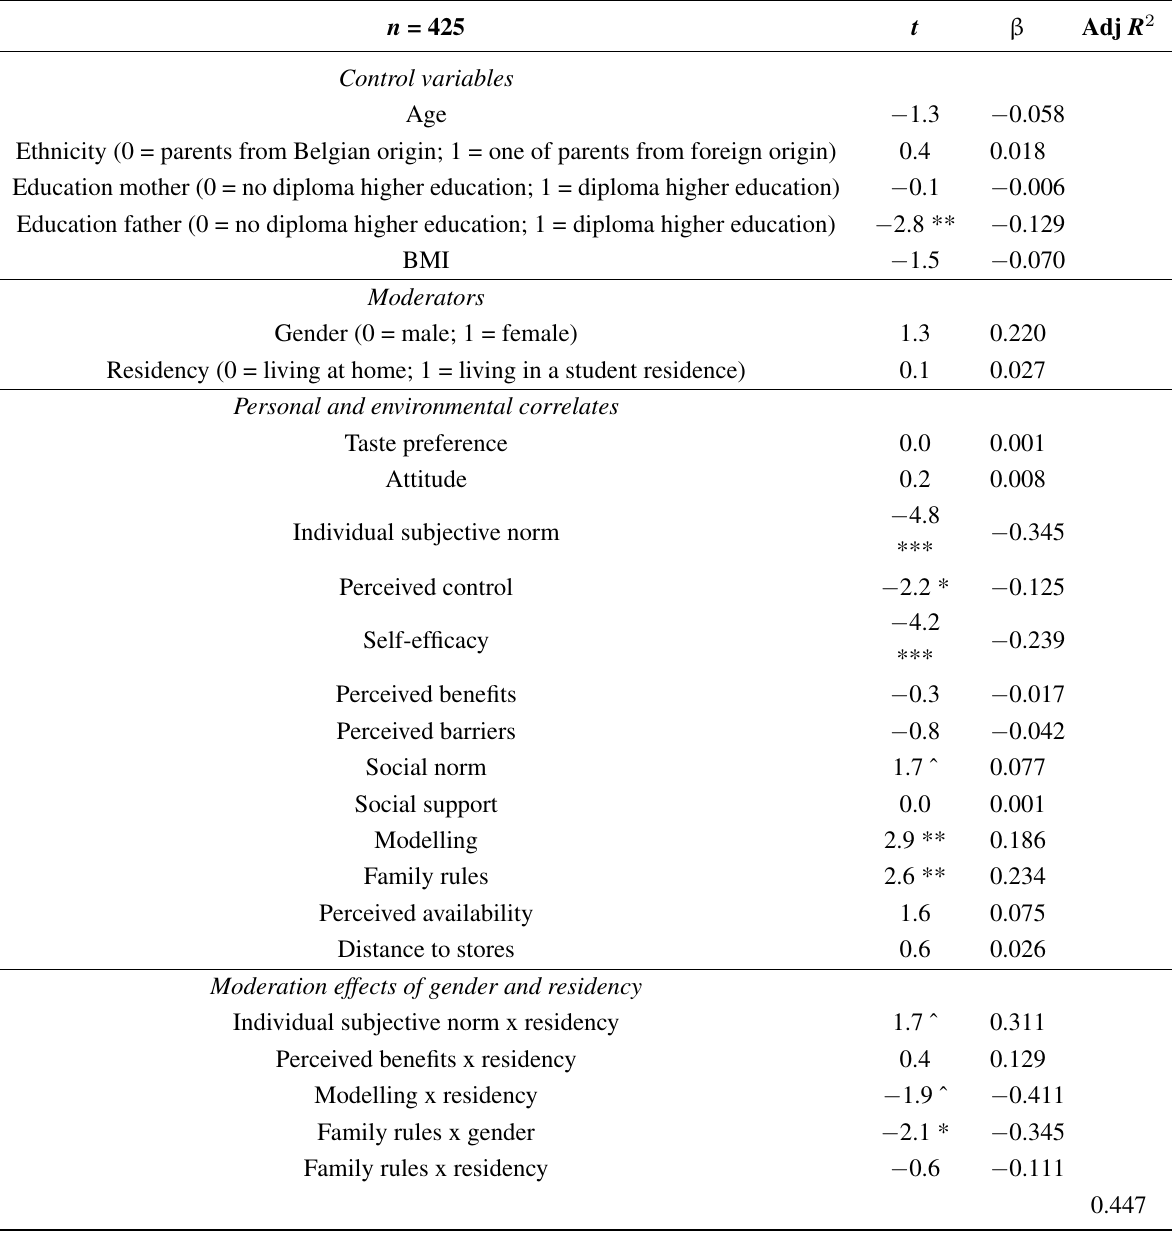
Table 3. Multivariate regression model of personal and environmental correlates of soft drink consumption in Belgian university students ( t -values, β -values, Adjusted R 2